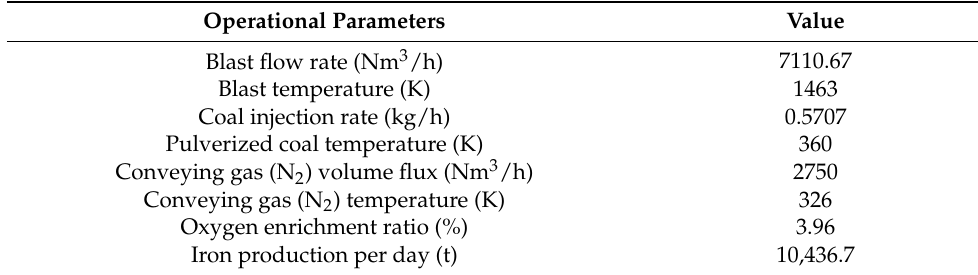
Table 5. Operational parameters adopted in the